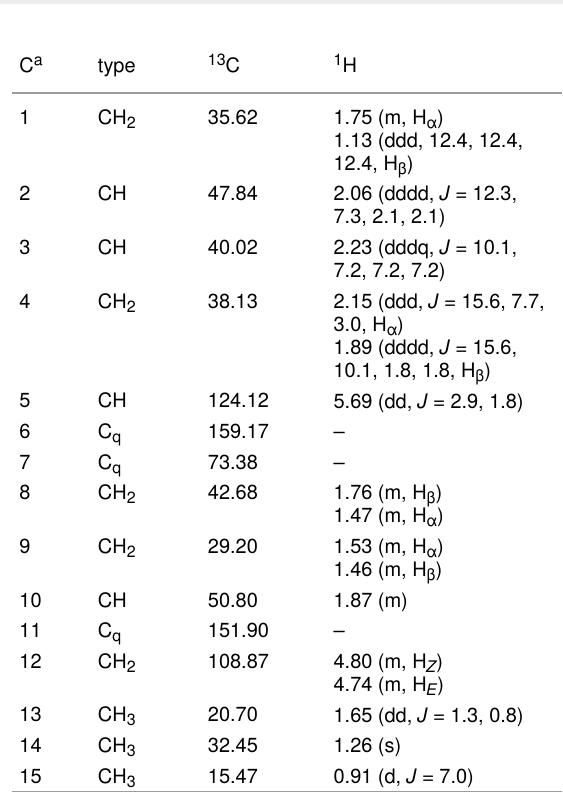
Table 1: NMR data of compound 17 (700 MHz, C 6 D 6